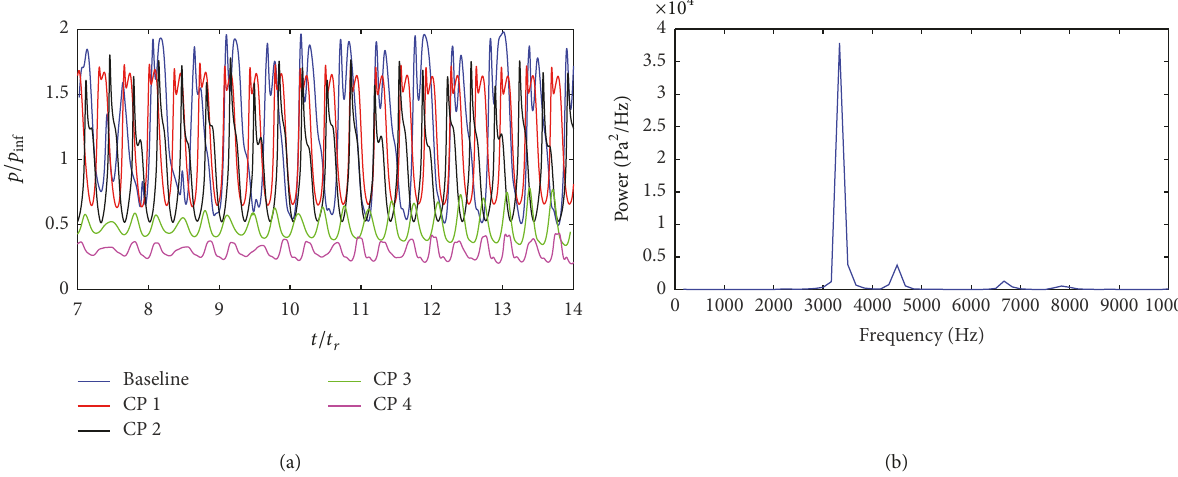
Figure 12: The results for the control point. (a) Pressure distribution for the baseline case and the cases with cover plate. (b) FFT analysis for the pressure data obtained from the control point (CP4).